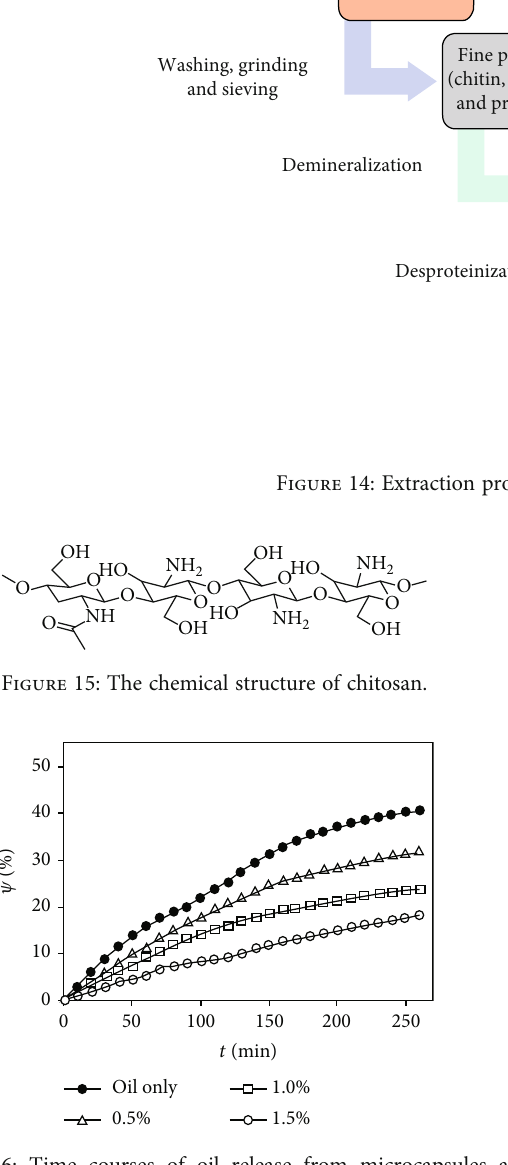
Figure 16: Time courses of oil release from microcapsules at di ff erent concentrations of chitosan. The symbols (black circle), (triangle), (square), and (white circle) denote concentrations of chitosan of 0 wt% (oil only), 0.5wt%, 1.0wt%, and 1.5wt%, respectively [44].